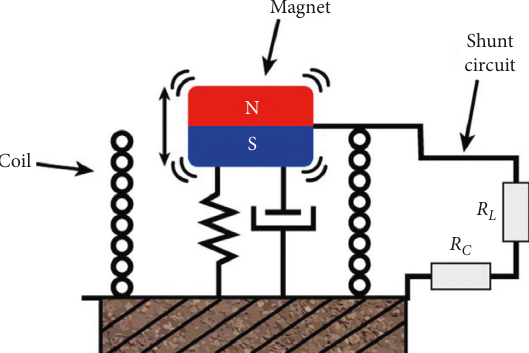
Figure 4: EMSD common configuration: a permanent magnet oscillates along a coil generating electricity from the vibration damping. This electricity is then reoriented to a load resistance to be dissipated externally or to be used or accumulated for other